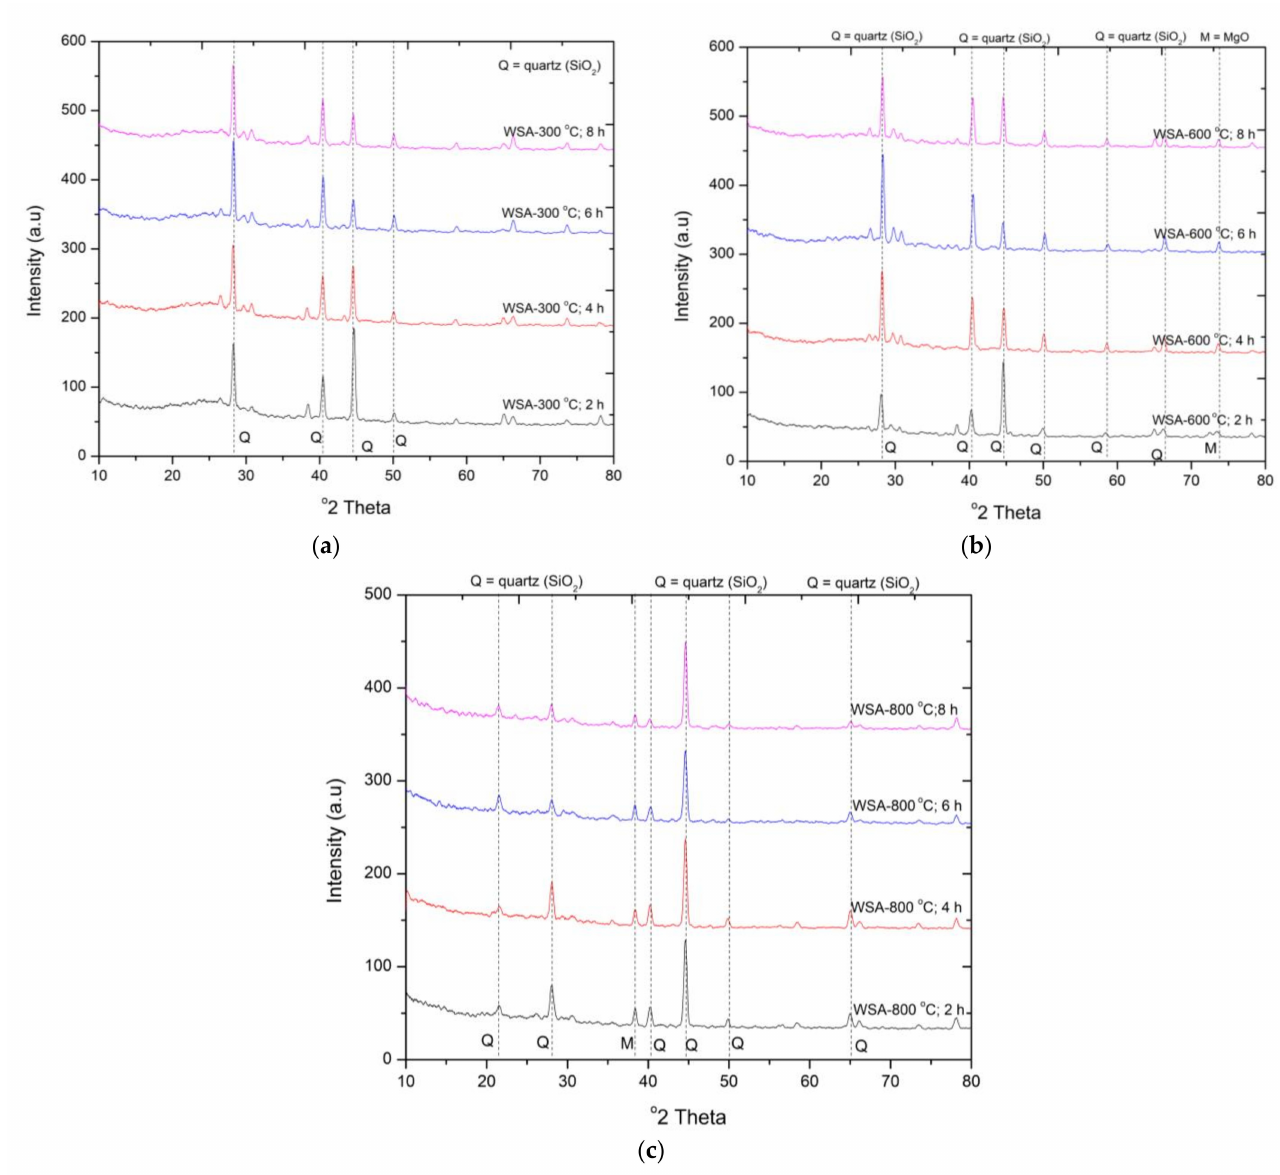
Figure 2. XRD pattern of rice WSA calcinated at ( a ) 300 ◦ C ( b ) 600 ◦ C and ( c ) 800 ◦